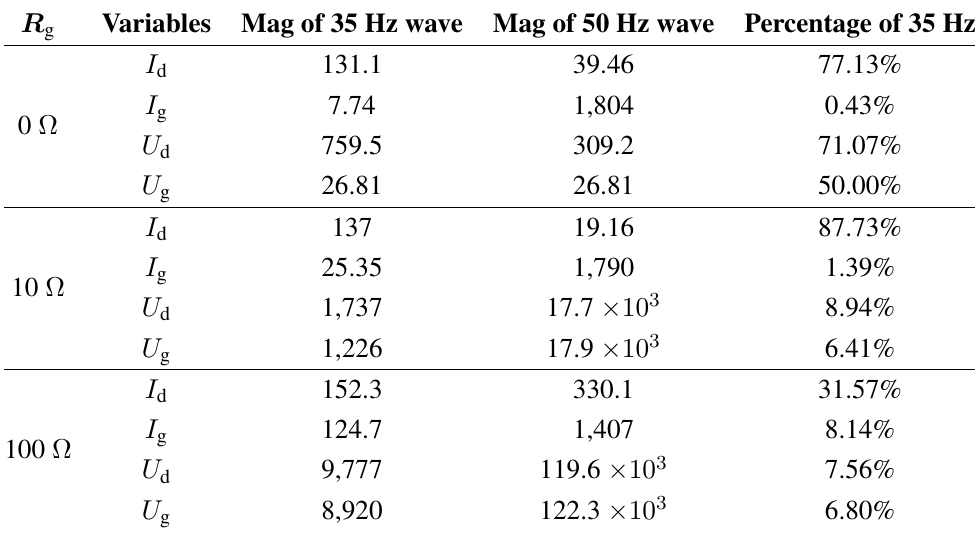
Table 2. Fast Fourier transformation analysis of currents and voltages with 138 wind